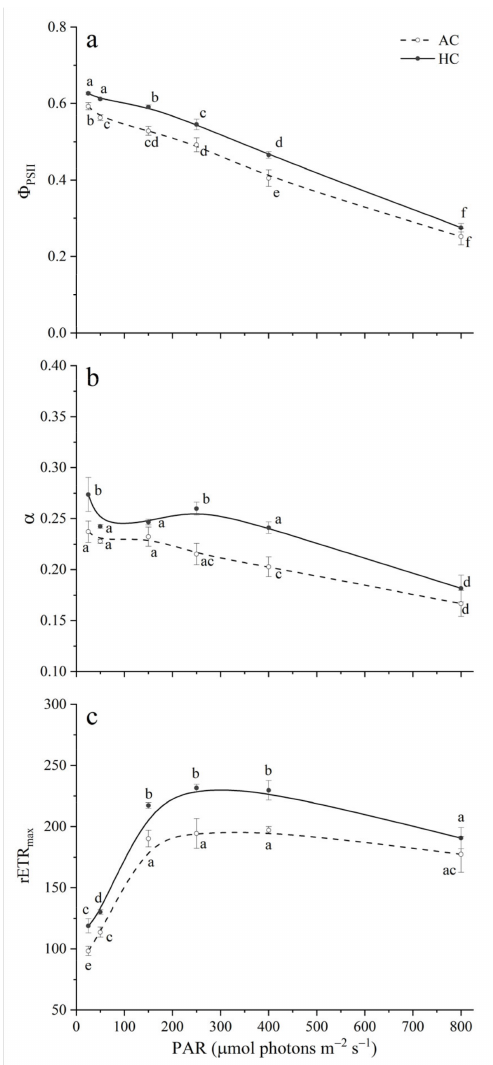
Figure 3. The effective quantum yield ( Φ PSII ) ( a ) and photosynthetic light-harvesting efficiency ( α ) ( b ), maximum electron transport rate (rETR max ) ( c ) of Synechococcus cells grown under different light levels combined with the ambient (AC, 415 µ atm, the dotted line) or elevated p CO 2 (HC, 1000 µ atm, the solid line). The α and rETR max parameters were derived from rapid light curves (see Figure S1 and Table S2). The values are means ± SD of triplicate cultures. Different letters indicate significant ( p < 0.05) differences among the